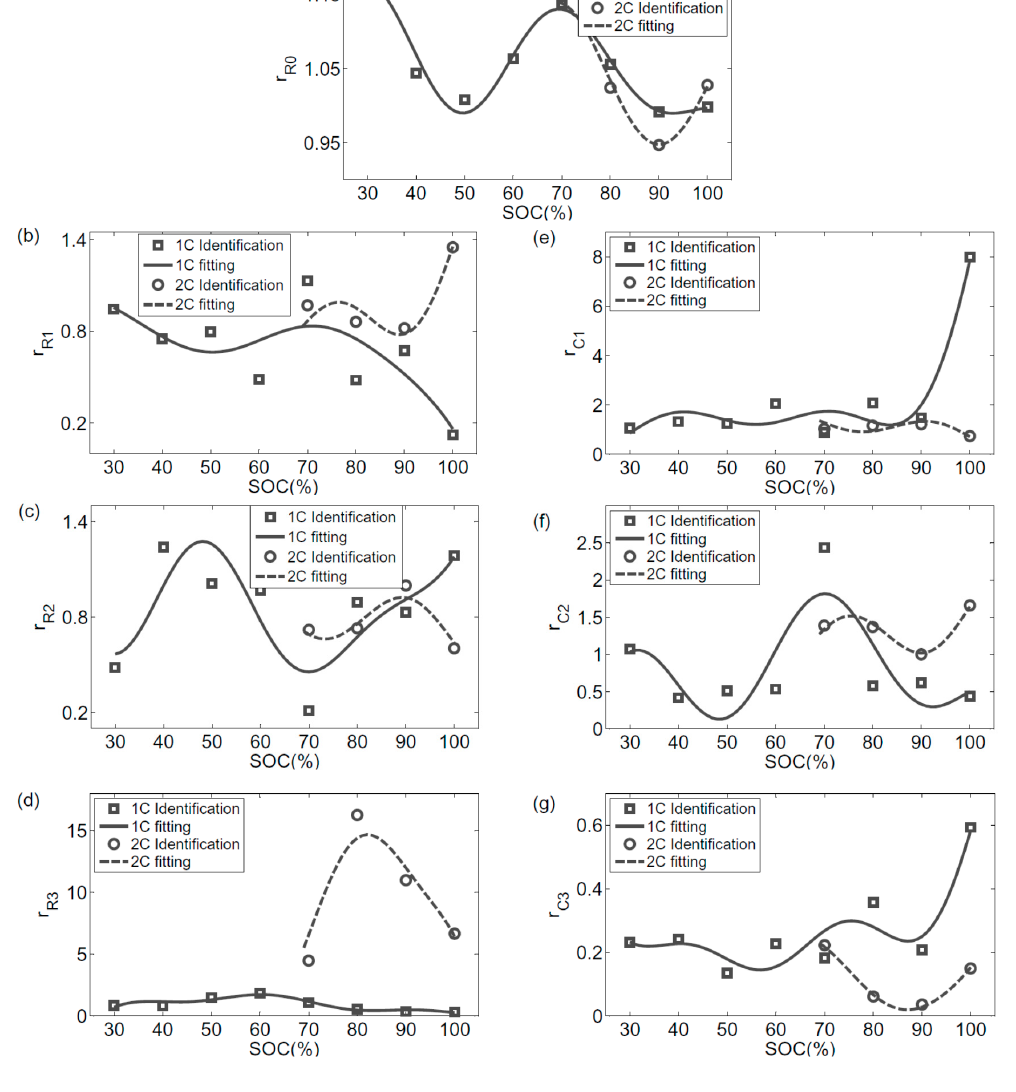
− 0.4339 Table 7. Parametric equation coefficients of the dashed lines in Figure 6. Subplots